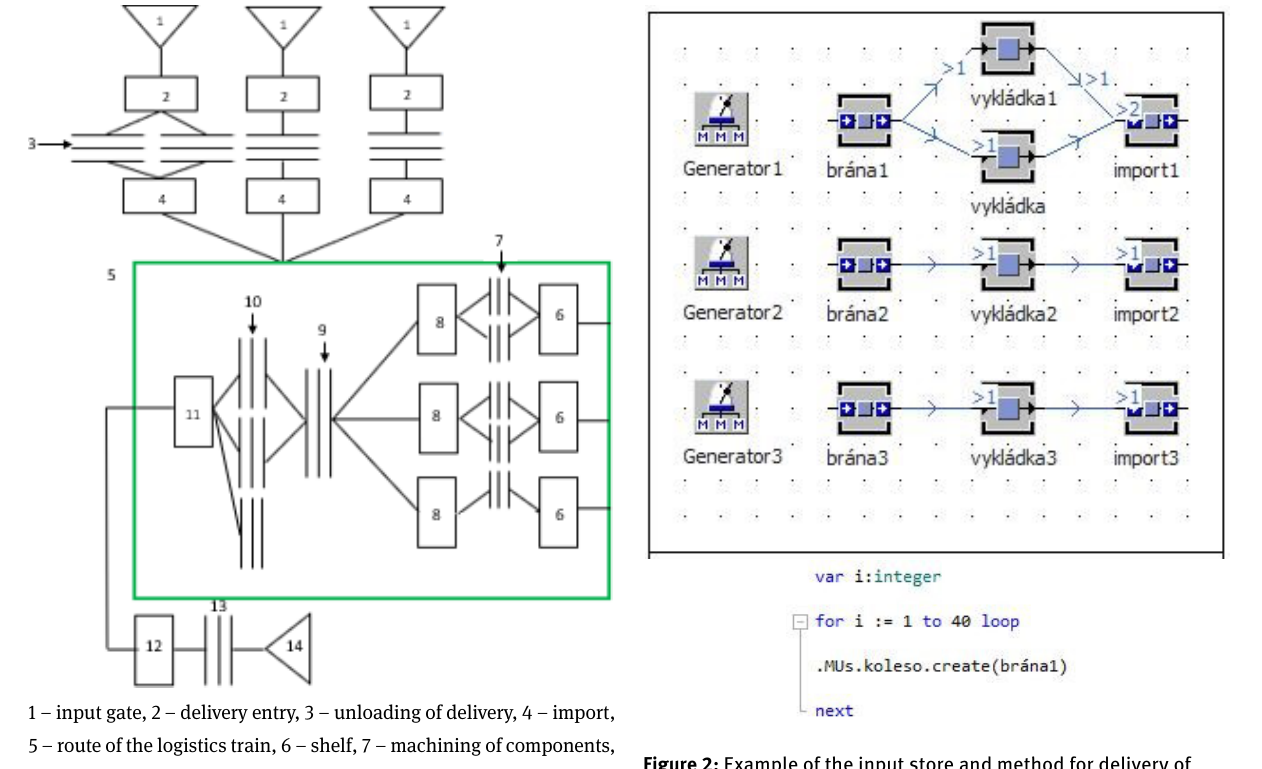
Figure 1: Bloch scheme of the simulation model